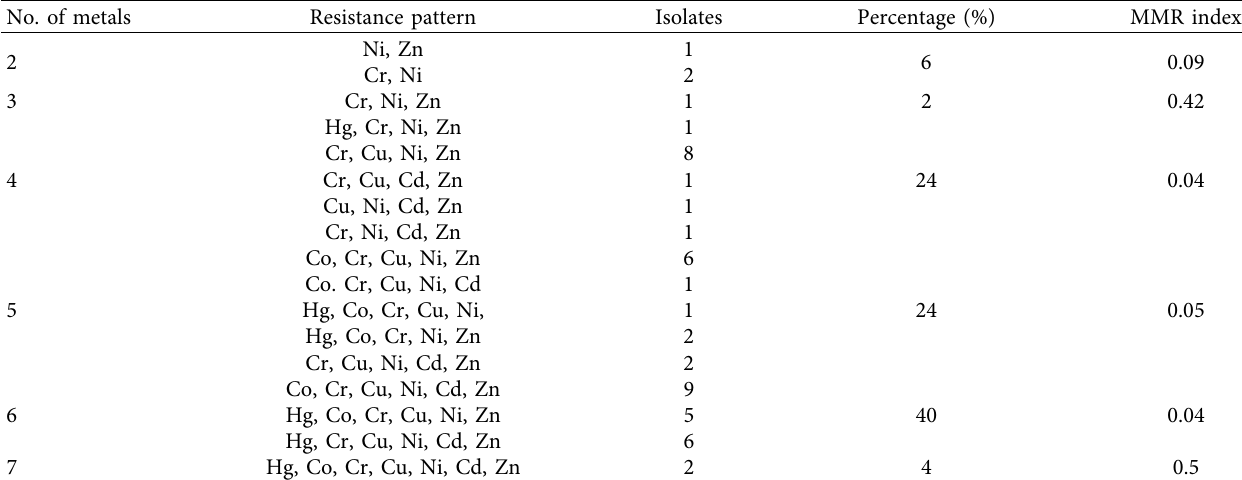
Figure 1: MIC range of heavy metals in P. vulgaris ( n � 50) from entire sampling sites of hospital Table 3: Metal resistance patterns in P. vulgaris ( n � 50) from the entire sampling site.